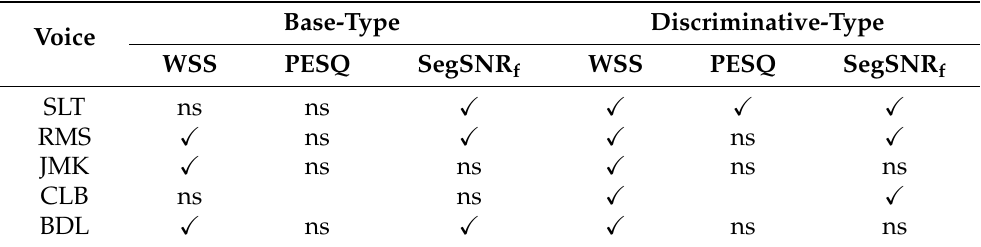
Table 5. Tukey’s test results. Ticks indicate a significant enhancement of the artificial speech, and ns means an improvement but not statistically significant. And empty space represent that no improvement were